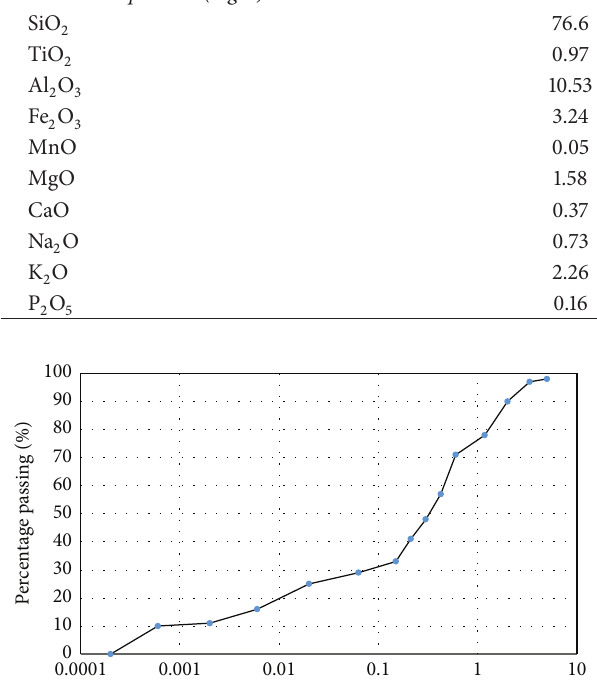
Table 2: Compaction pressure used for making earth blocks in previous studies.